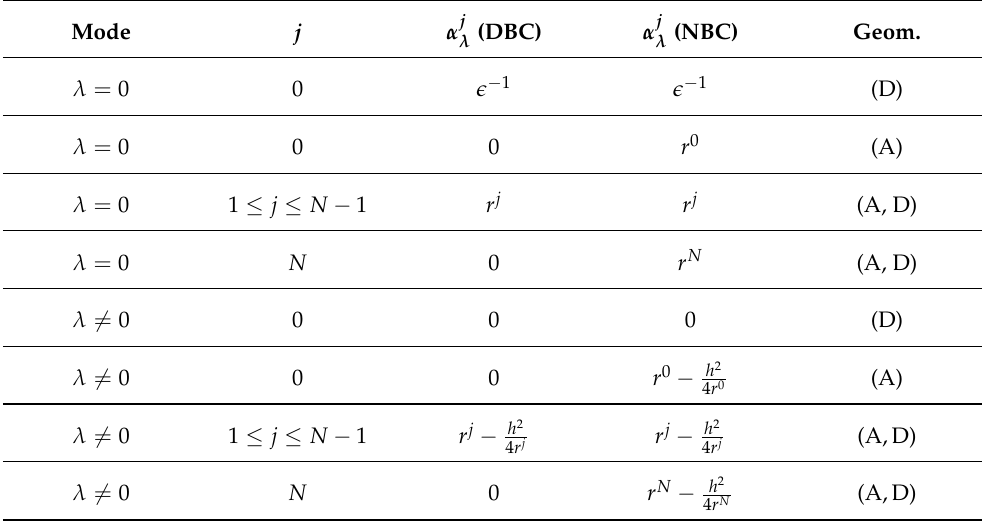
that define DBC and NBC for an annulus (A) and a disc (D). λ